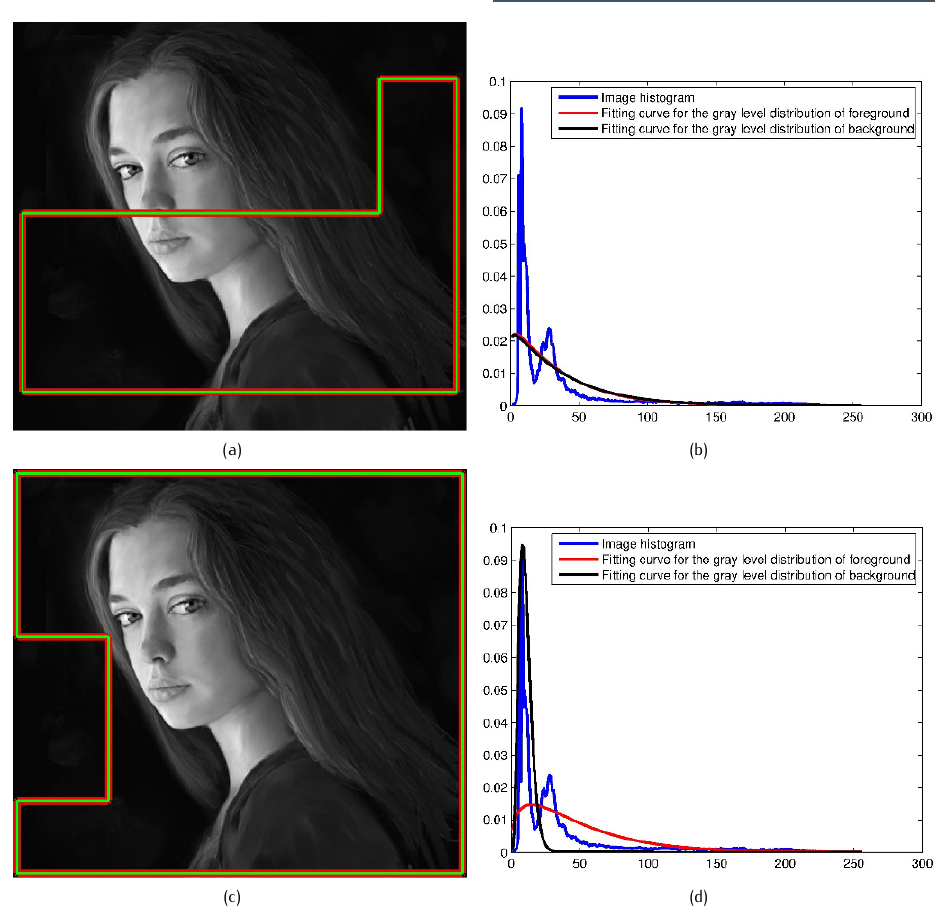
Figure 3. Comparison of different initialization methods. (a) shows a certain initial curve. Under this separation, (b) illustrates the image histogram and the fitting curves for the gray level distribution of foreground and background. The initial curve shown in (c) is obtained by the proposed method, and (d) demonstrates the image histogram, a gentle fitting curve for the intensity value distribution of foreground, and an acuminate one for background.